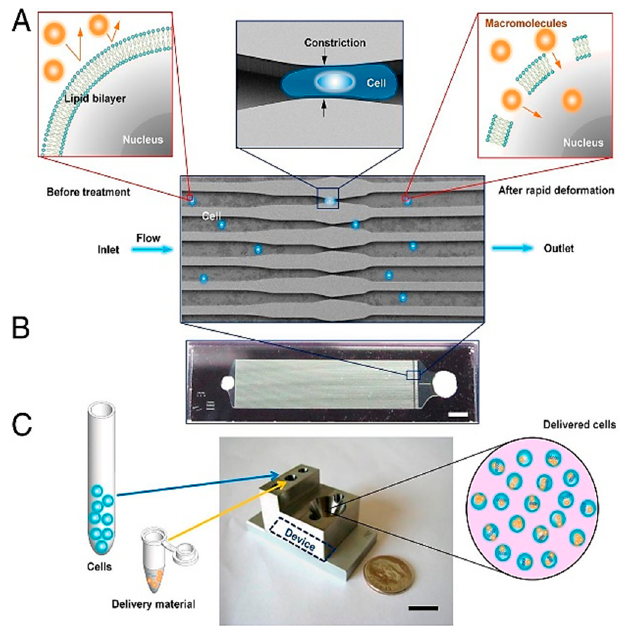
Figure 26. ( A ) Mechanism of formation of transient pores in cells on passing through the microconstrictions in the device designed by Sharei et al.; ( B ) Image of the finished device with a zoomed-in view showing the cell flow channels with the microconstrictions. ( C ) Image of the device packaging. “Permission to reprint obtained from PNAS [170]”.